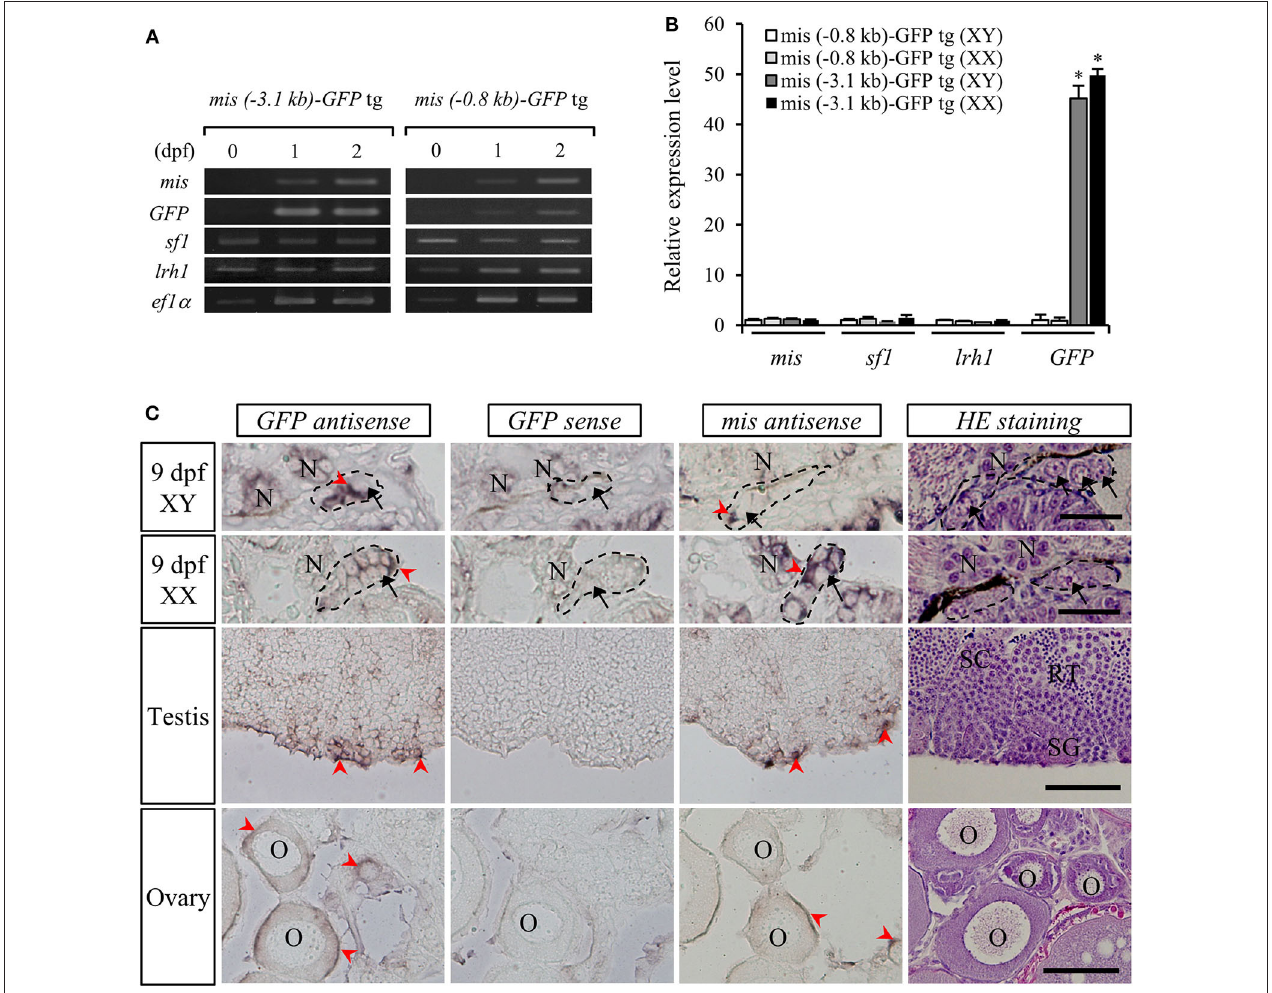
FIGURE 3 | Gene expression in mis-GFP transgenic (tg) medaka. RT-PCR analysis of mis , GFP , sf1 , and lrh1 mRNAs in the embryos at 0-dpf, 1-dpf, 2-dpf (A) and 9-dpf (B) . * p < 0.05. In situ hybridization of mis and GFP transcripts and hematoxylin/eosin (HE)-stained sections in gonads of both sexes (C) . Arrow, germ cell; arrowhead, positive cell; SC, spermatocyte; SG, spermatogonium; RT, round spermatid; O, oocyte; N, nephridium. Scale bar: 100 µ